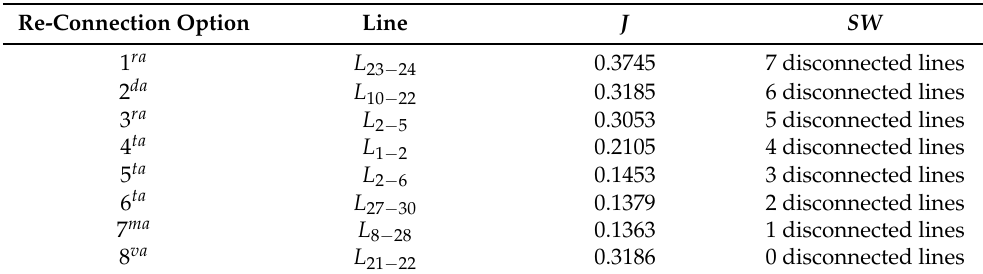
Table 4. Line reconnect options for the 30 bus bar